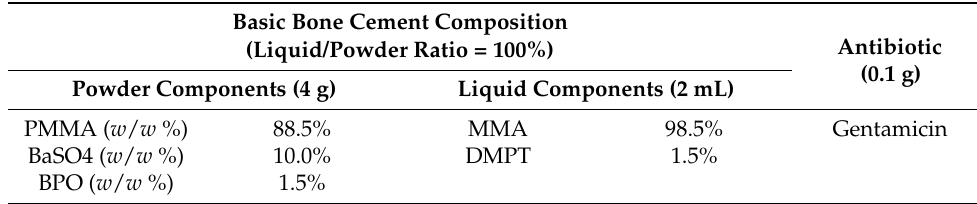
Table 1. Composition of basic PMMA bone cement in this study.